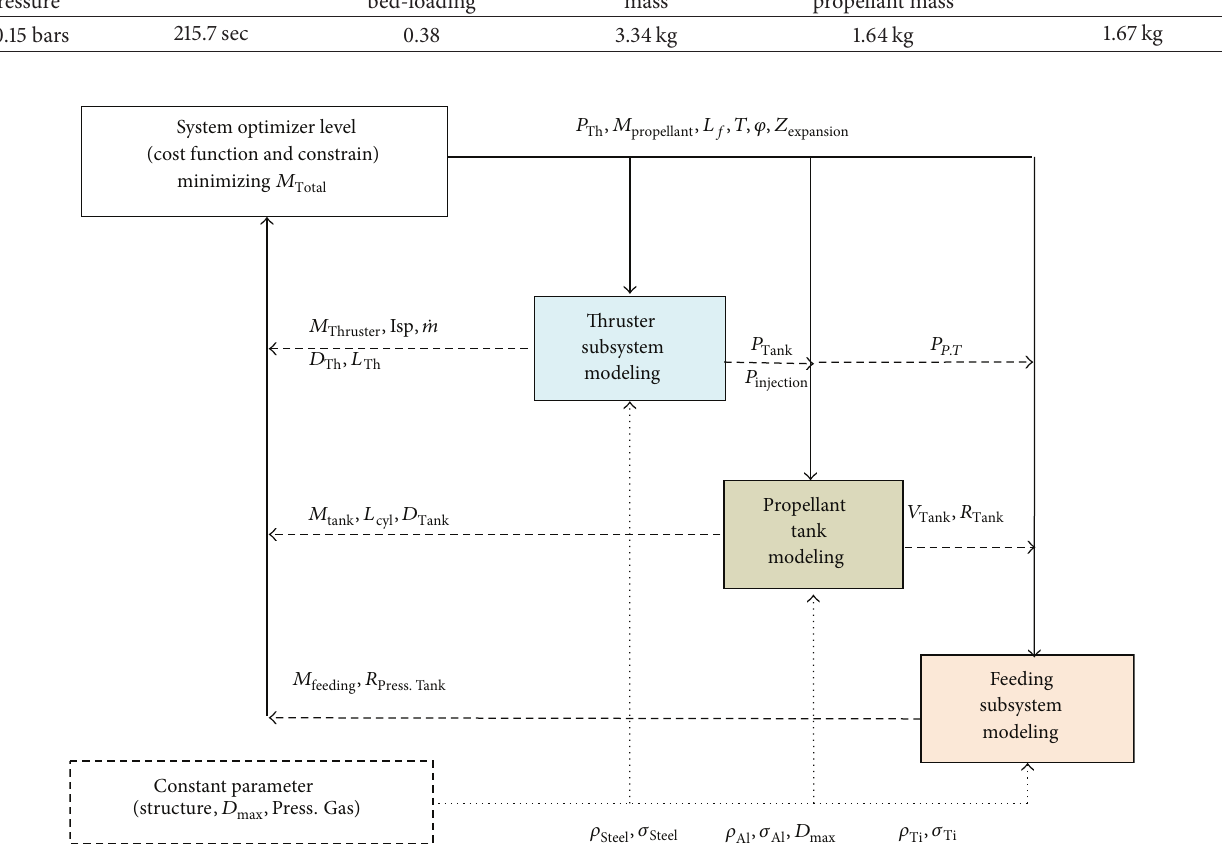
Figure 13: Multidisciplinary design optimization algorithm for the hydrazine propulsion